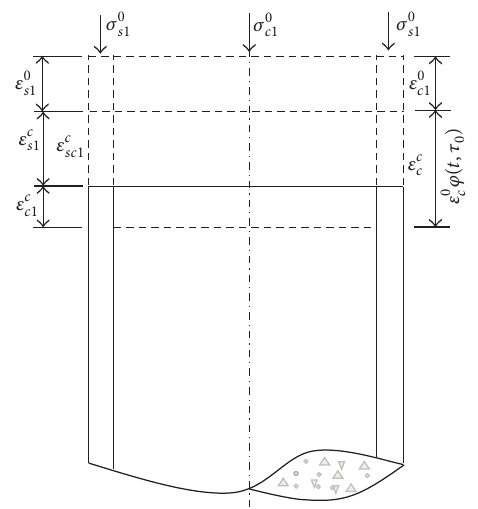
Figure 7: Creep strain of CFST member under axial compression.